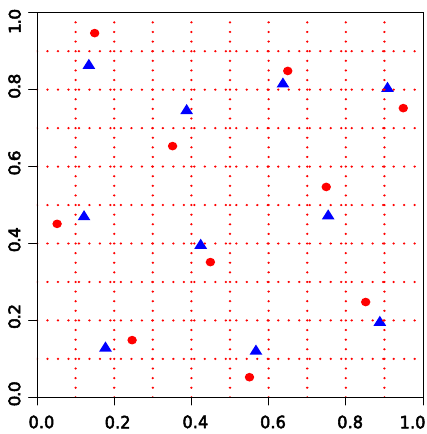
Figure 2. Scatterplots of rep-points for uniform distribution on [ 0,1 ] 2 generated by SP method ( (cid:115) ) and PEKD method ( (cid:108) ) . From Figure 2, rep-points ( (cid:108) ) based on kernel γ